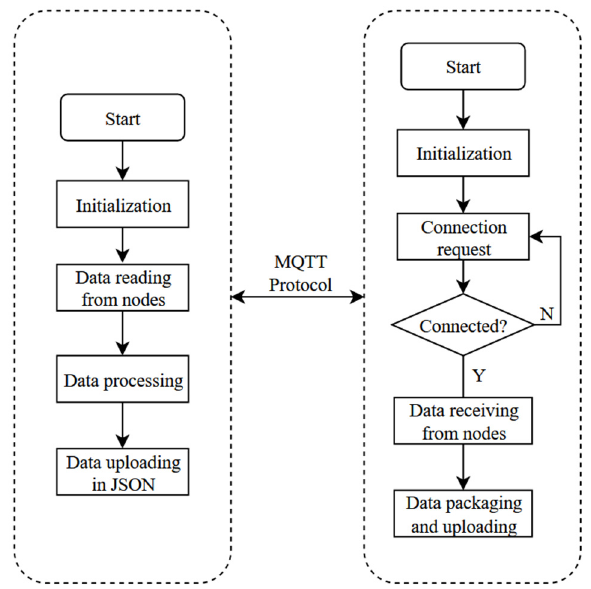
Figure 9. Block program diagram of wireless transmission network.